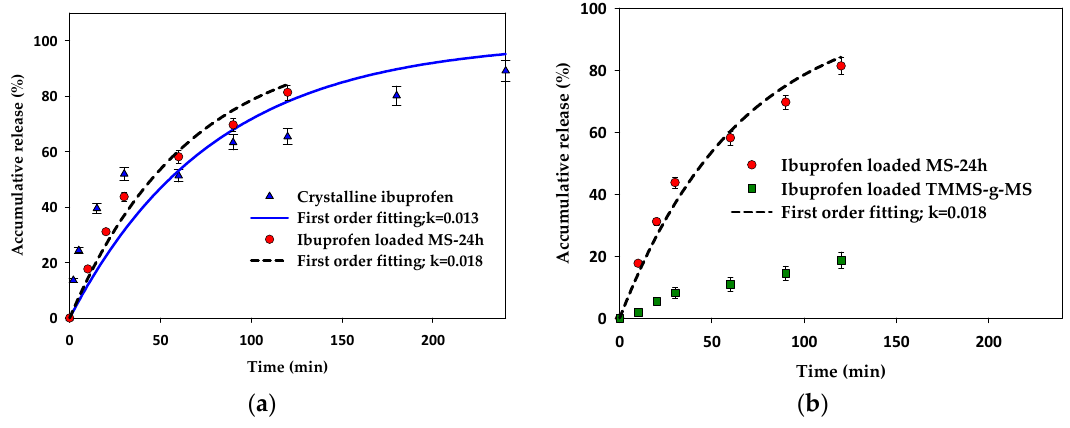
Figure 9 . Accumulative release (%) of ( a ) crystalline ibuprofen compared with ibuprofen-loaded MS-24h and ( b ) ibuprofen-loaded MS-24h compared with ibuprofen-loaded TMMS-g-MS with first order kinetics model fitting.